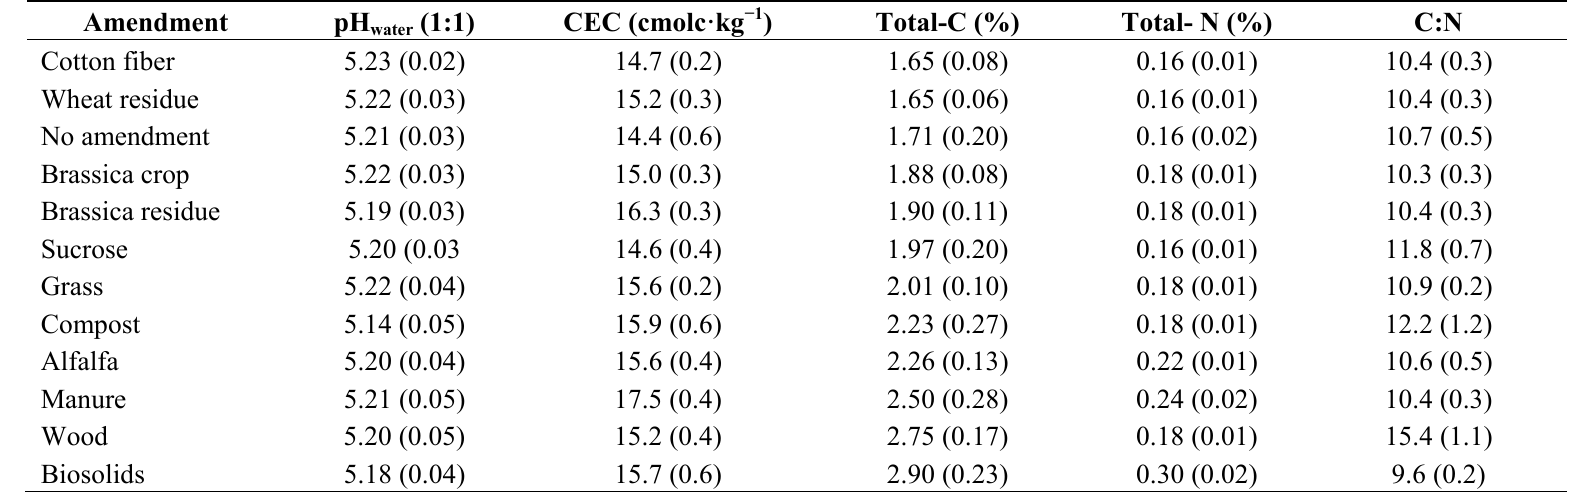
Table 1. Final soil properties † from a field study in which amendments were added to agricultural soil at the Columbia Plateau Conservation Research Center, Pendleton, OR, USA in 2002 through